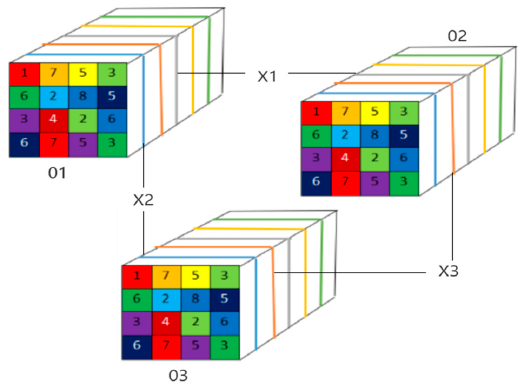
Figure 4. Matrix layer number selection diagram.